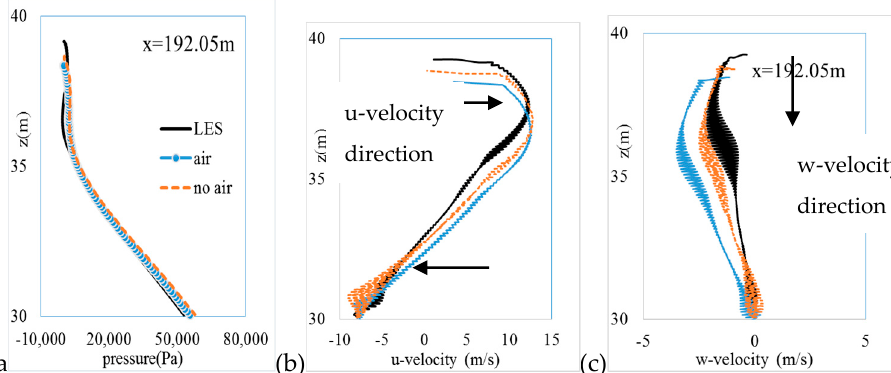
Figure 16. ( a ) Pressure profile; ( b ) u-velocity component profile and ( c ) w-profile at the middle of the stilling basin.